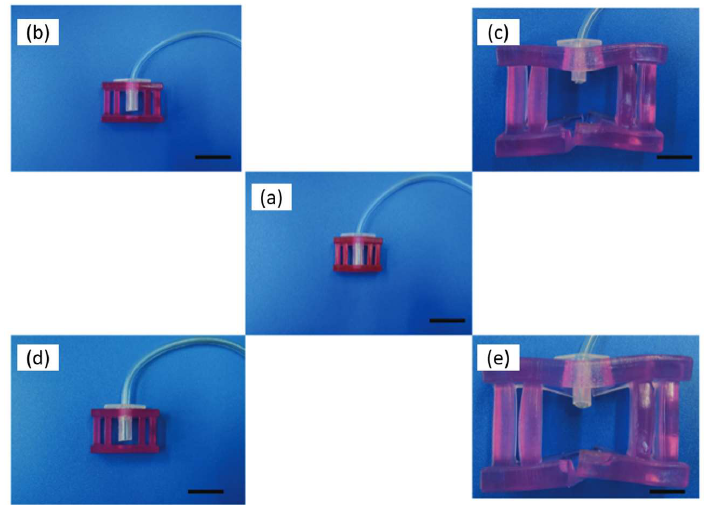
Figure 14. 3D printed valve structure of FA70(80) at different conditions. ( a ) Dry, ( b ) pH 2.0/37 °C ( c ) pH 7.4/37 °C, ( d ) pH 2.0/6 °C and ( e ) pH 7.4/6 °C. (Bar: 2 cm.). Reprinted with permission from [110].